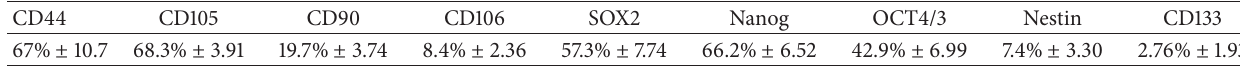
Table 1: The percentage and SD of the cells that expressed various stem cell markers.